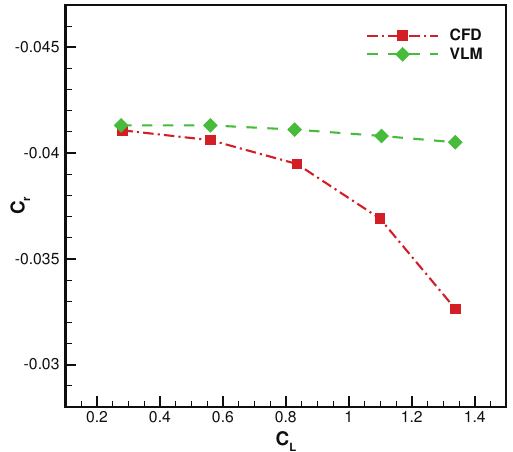
Figure 20. Ailerons: rolling moment against lift coefficient.